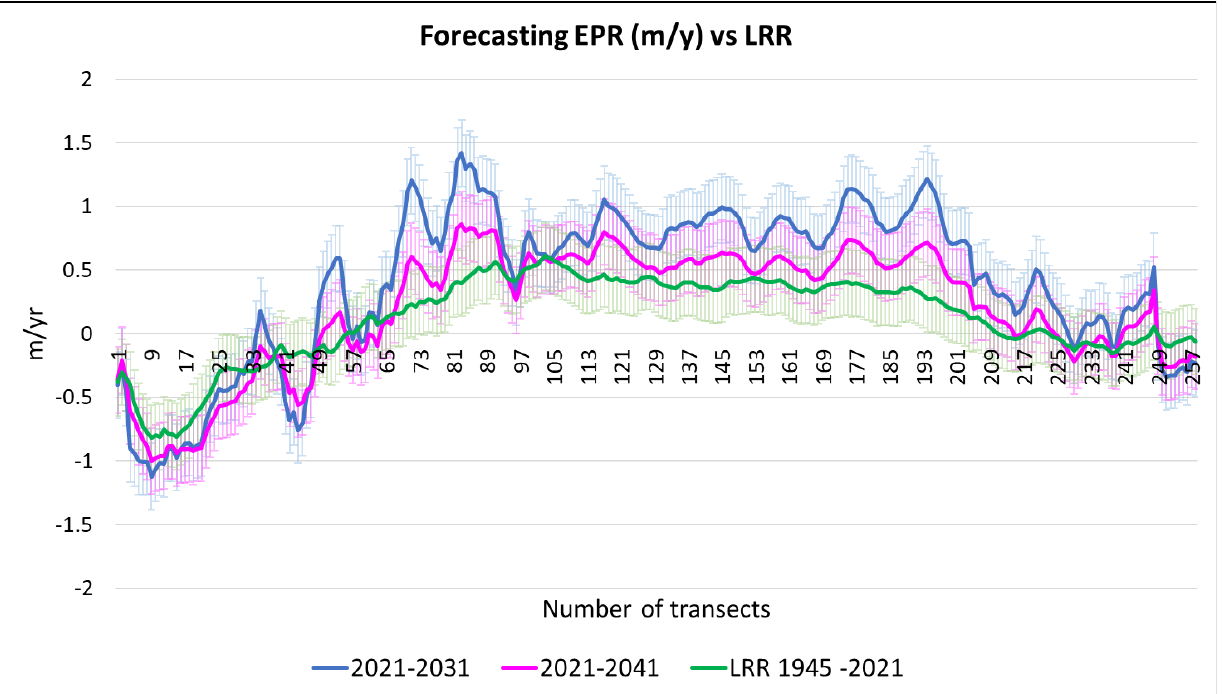
Figure 16. Forecasted EPR for the periods 2021 – 2031 and 2021 – 2041 vs. LRR (1945 – 2021). The prediction interval has been calculated at ±0.26 m/yr. Table 5. Comparison of the forecasted EPR rates and LRR 21 .